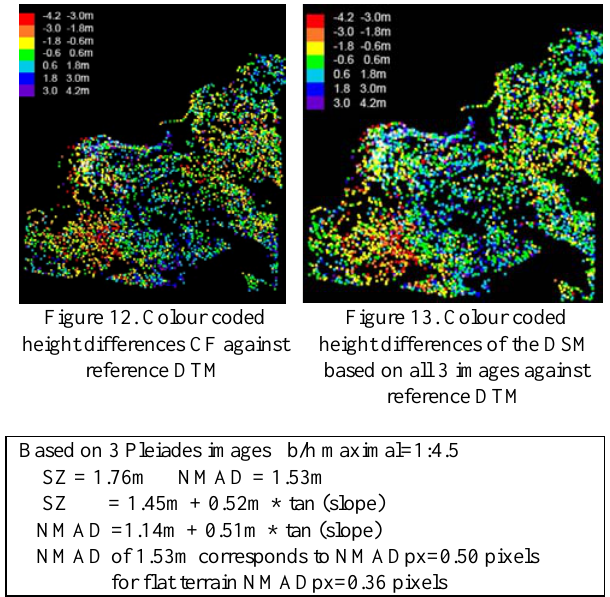
Table 6: accuracy of height model based on all 3 Pleiades images together